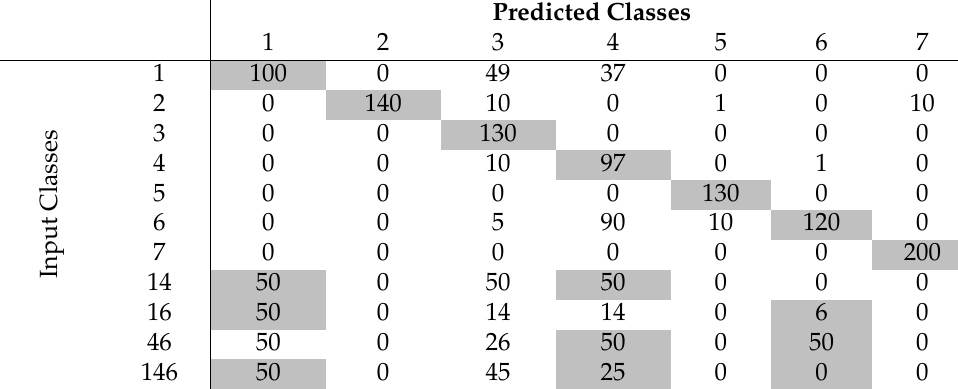
Table 5. Hybrid confusion matrix of independent